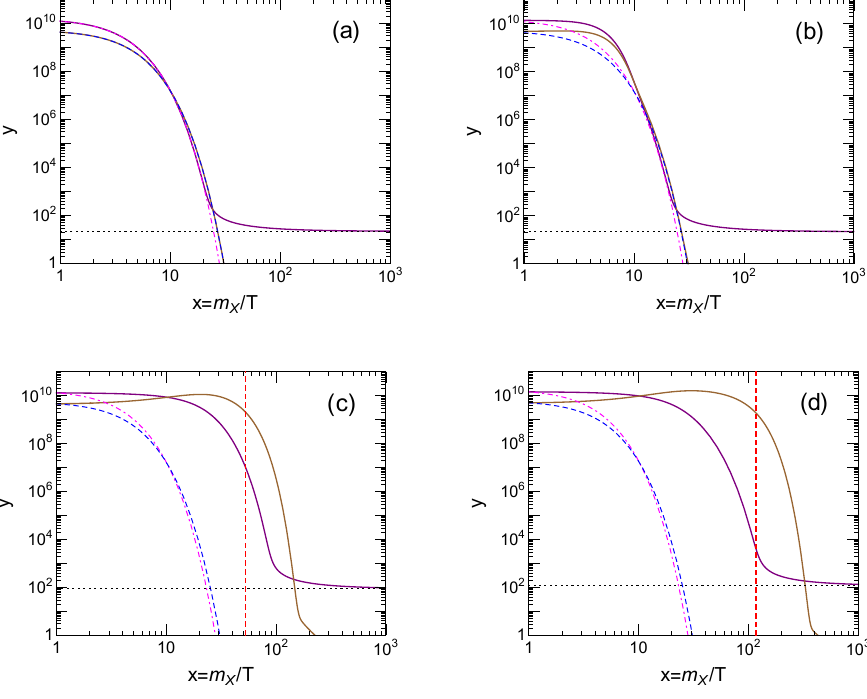
Figure 7 . Evolutions of the dark matter yield y X and mediator yield y S , where the parameters given in eq. (5.1) are used. The purple solid and brown solid curves stand for y X and y S , respectively, while the magenta dashed-dotted and blue dashed curves show their corresponding yields under thermal equilibrium. The horizontal line denotes the asymptotic yield of the dark matter, y 1 In (a), (b), (c), and (d), we separately use ( (cid:18); (cid:14) ) = (0 : 00043 ; 0) ; (2 (cid:2) 10 (cid:0) 10 ; 0) ; (1 : 2 (cid:2) 10 (cid:0) 11 ; 0),